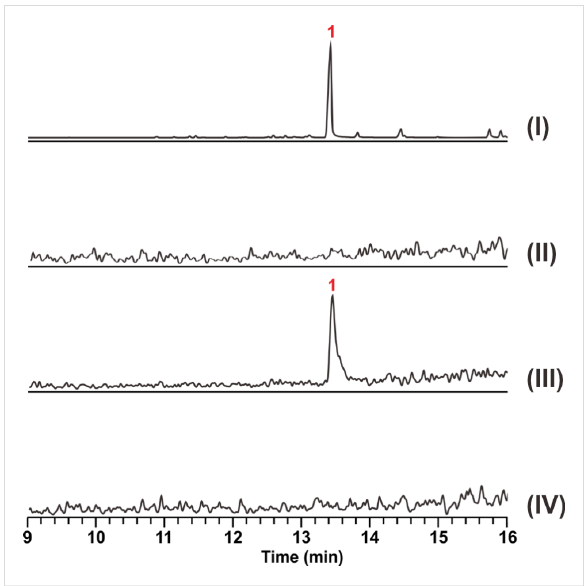
Figure 3: GC–MS chromatogram of products in vivo (I), in yeast YZL141 (II), in vitro Tvi09626 with FPP (III), and boiled Tvi09626 with FPP